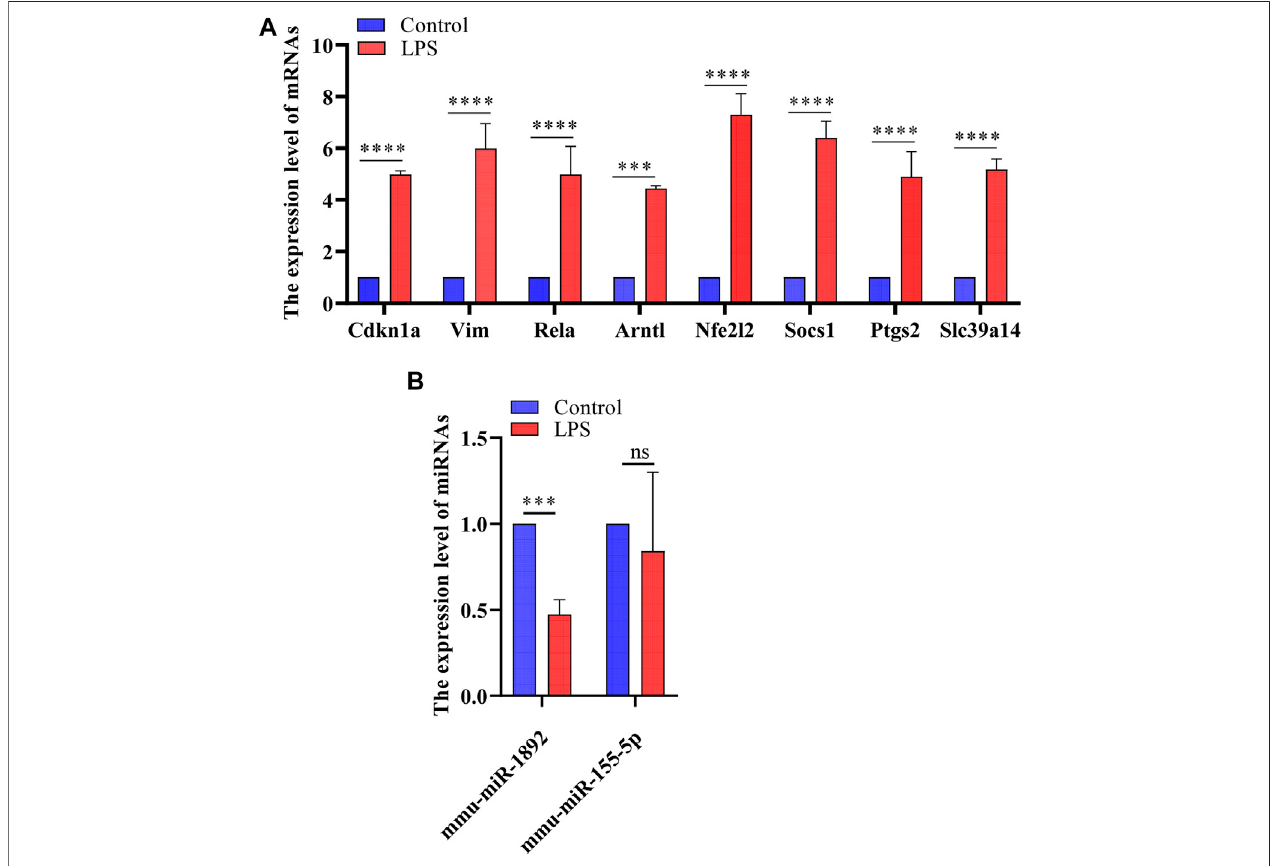
FIGURE 7 | The results of real-time PCR. (A) Detection of FRGs expression in control and LPS treat HL-1 cells using RT-qPCR (n = 3), compared with the control group,theexpressionofFRGswasupregulatedinHL-1cellstreatedwithLPS. (B) DetectionofmiRNAsexpressionusingRT-qPCR( n =3),theexpressionofmmu-miR-1892was signi fi cantly down-regulated in LPS-treated HL-1 cells. ***, p < 0.001; ****, p < 0.0001; ns, no signi fi cant. Error bars represent the mean ± SD of triplicate experiments.